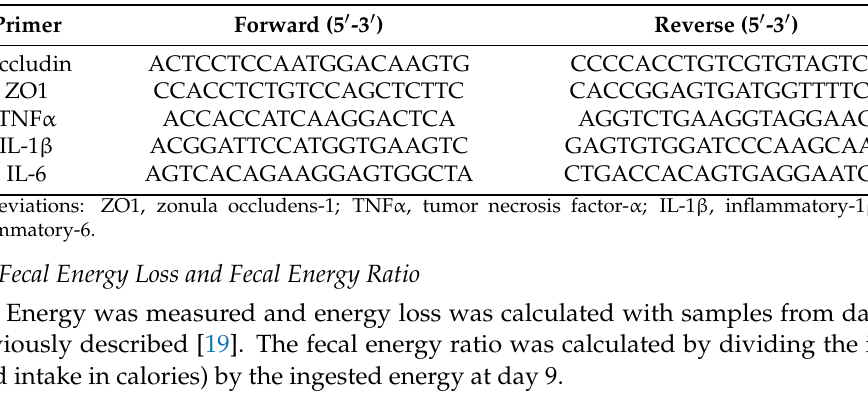
Table 2. Primer sequences used in quantitative real-time